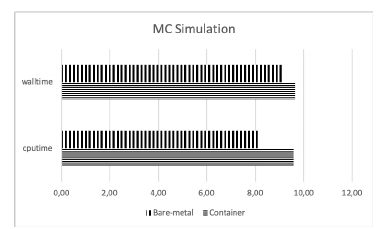
Figure 6. Timing comparison for digitization test.